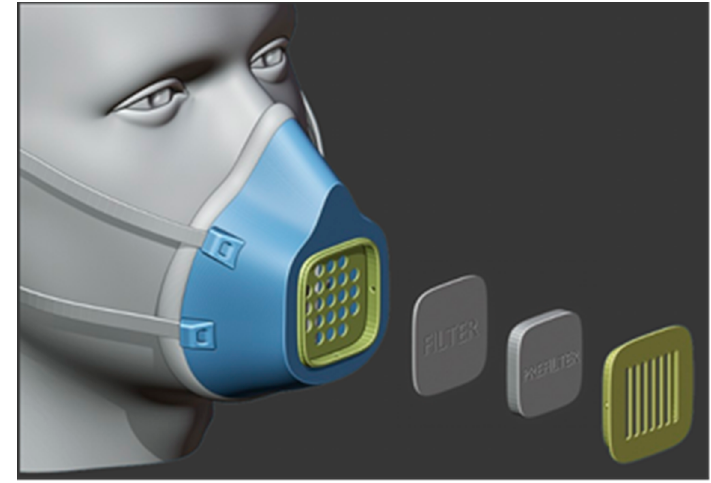
Figure 11. COVID-19 mask by Lafactoria3d made of PLA.